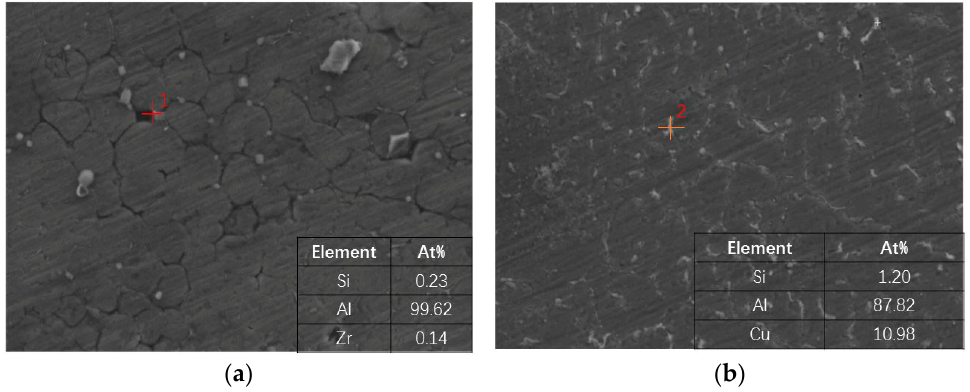
Figure 4. EDS analysis of boundary ( a ) Point 1; ( b ) Point 2.